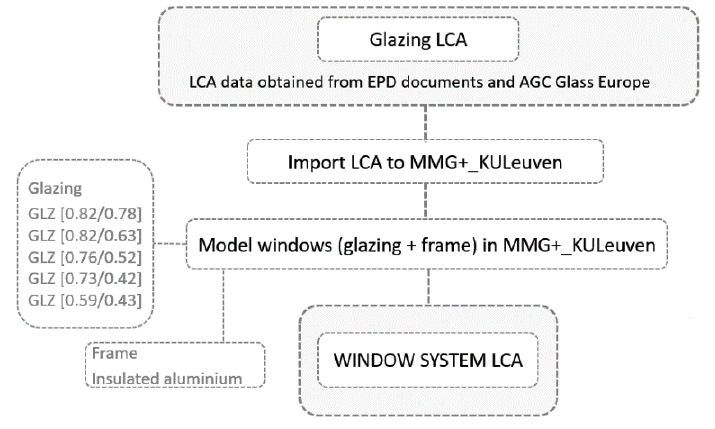
Fig. 2 Window system LCA